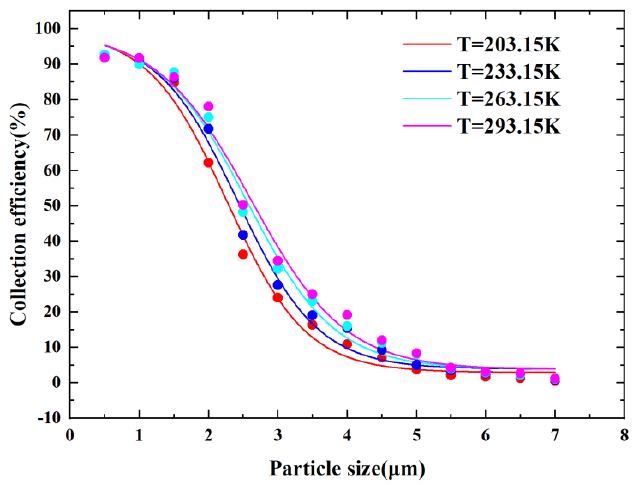
Figure 11. CE curves at different T